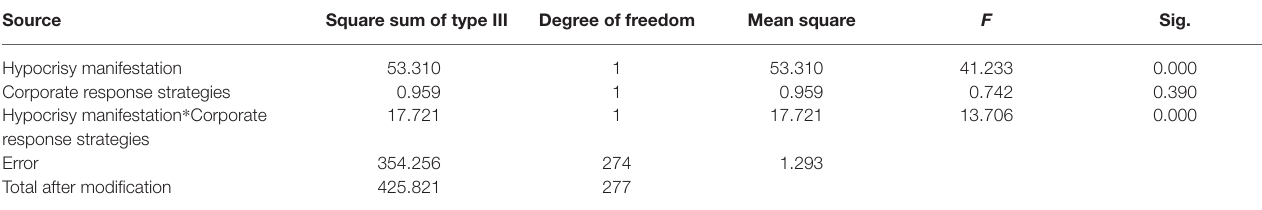
TABLE 5 | Results of the intersubject effect test.